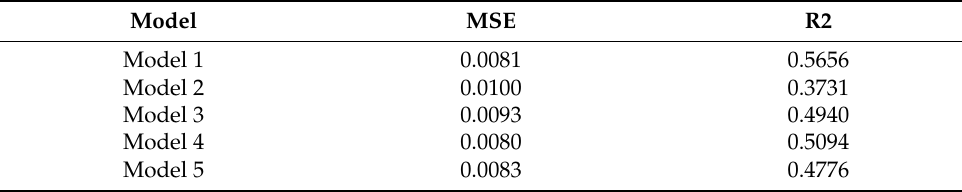
Table 2. Prediction results of different models on the test set.